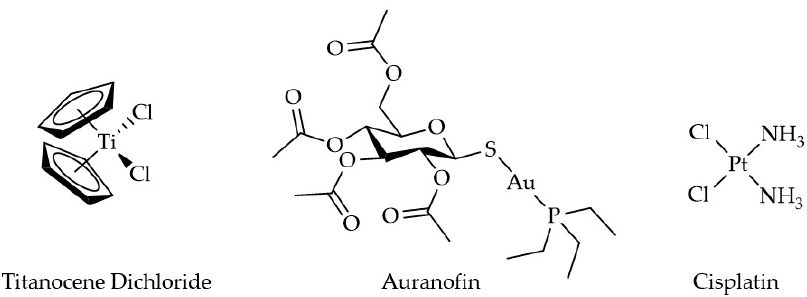
Figure 1. The chemical structures for titanocene dichloride, auranofin, and cisplatin.